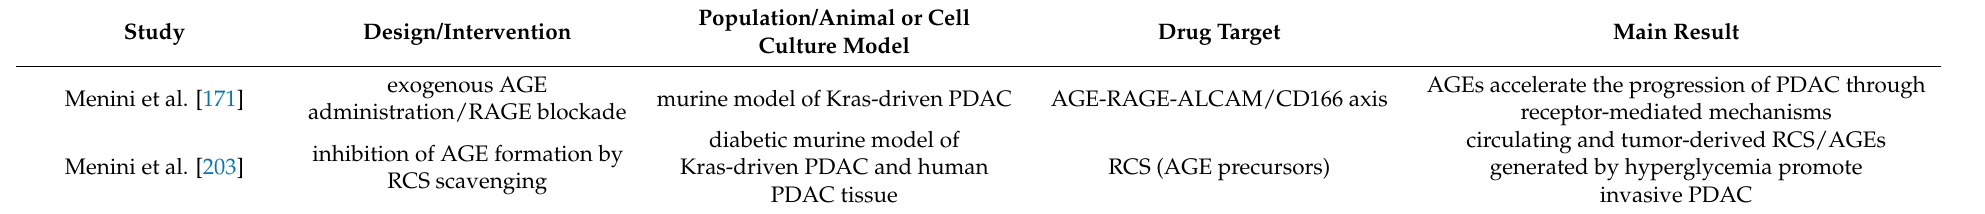
Drug Target Main Result AGEs accelerate the progression of PDAC through receptor-mediated mechanisms circulating and tumor-derived RCS/AGEs RCS (AGE precursors) generated by hyperglycemia promote invasive